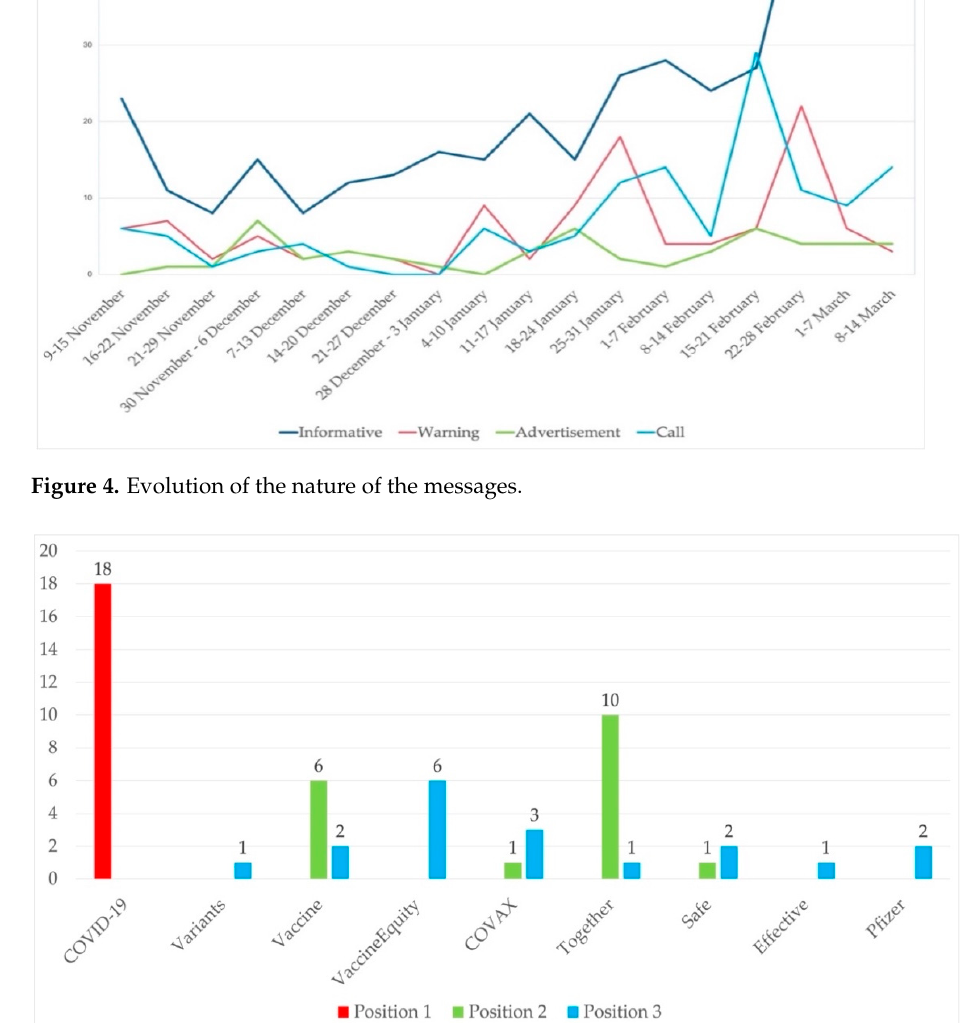
Figure 5. Number of weeks in which each term was among the three most frequently used.